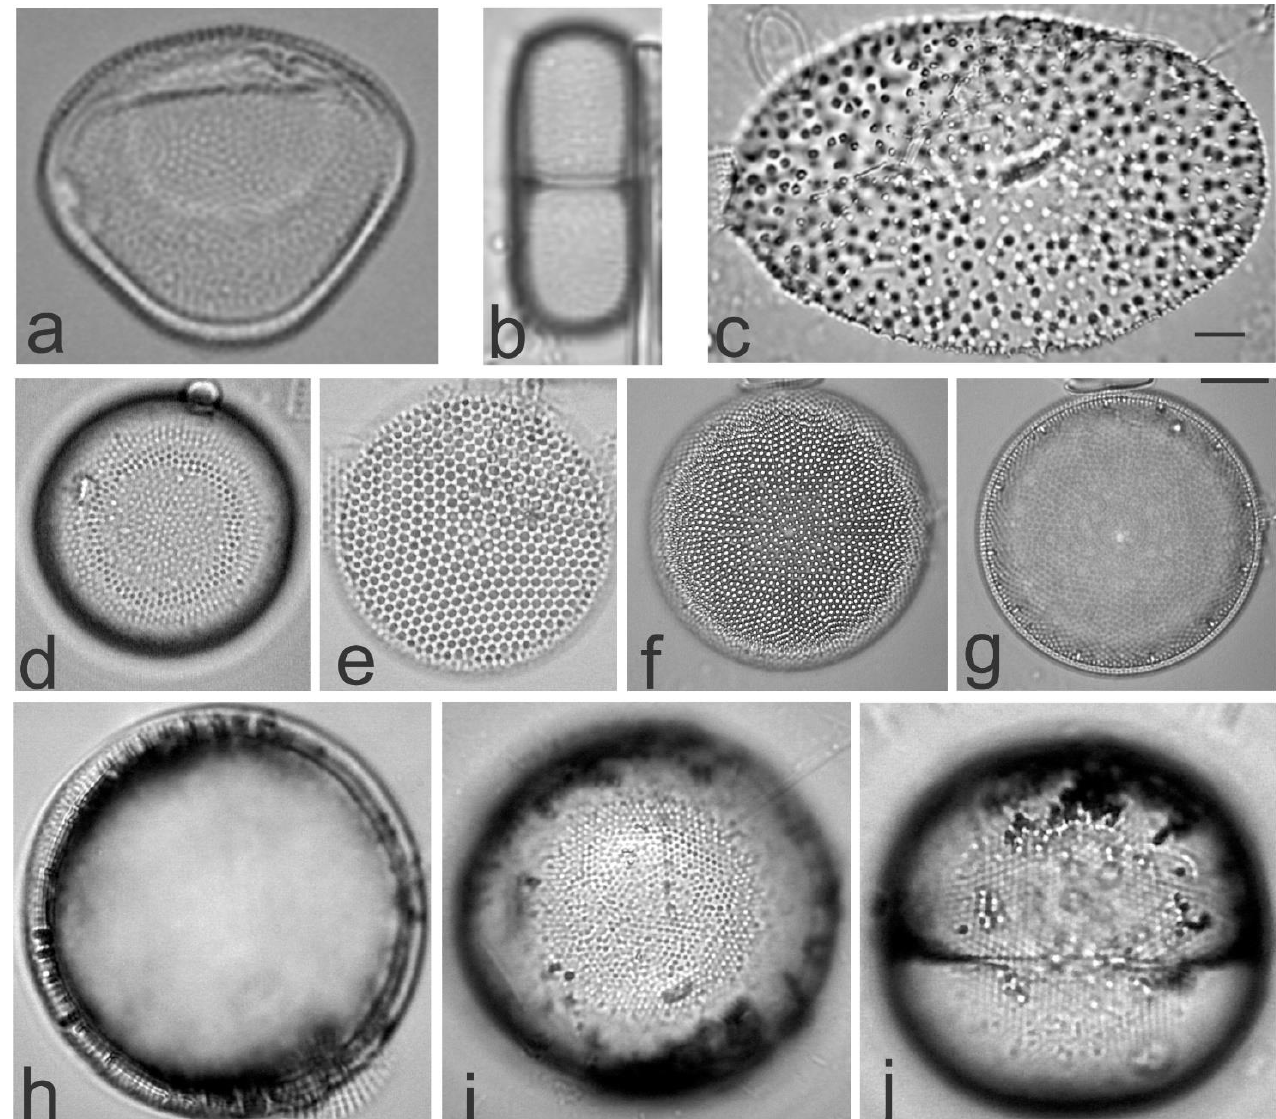
Figure 6. ( a ) Hemidiscus sp.?; ( b ) Podosira baldjickiana ; ( c ) resting spore; ( d ) Actinocyclus subtilis ; ( e ) Thalassiosira eccentrica ; ( f , g ) A. octonarius ; ( h – j ) Podosira montagnei. Scale bars: ( c ) = 15 μm; rest = 10 μm.